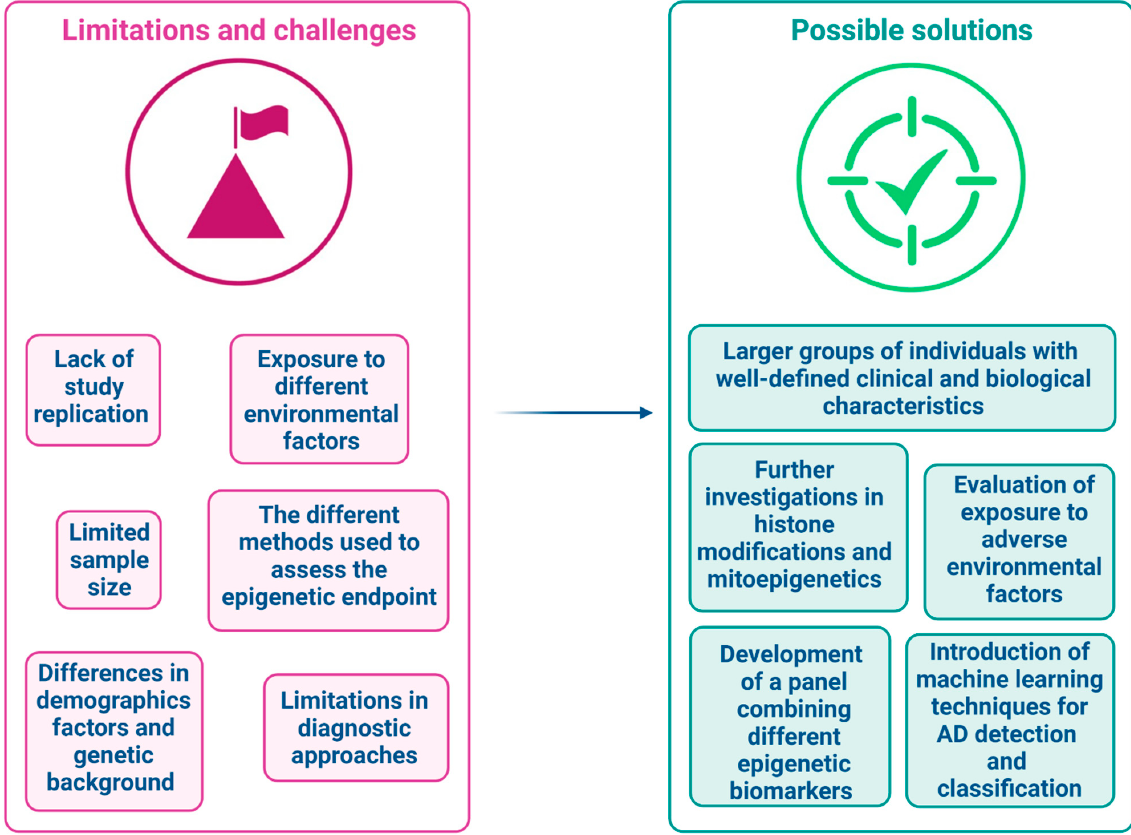
Figure 2. Use of epigenetic peripheral biomarkers for early diagnosis of AD: main limitations, challenges and possible solutions .